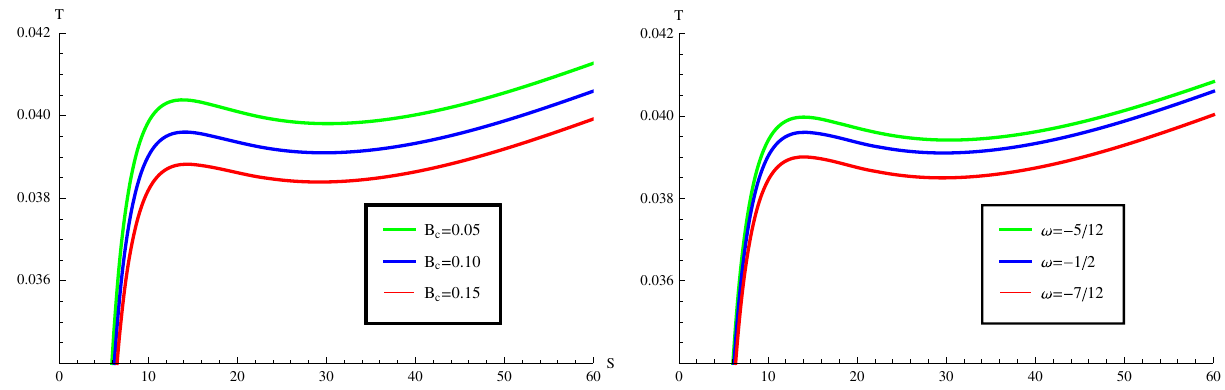
Fig. 3 The simulated phase transition and the boundary of a two-phase coexistence on the base of isobaric in the T – S diagram for charged anti-de Sitter black holes with differential B c and ω . The left figure shows Q = 1 ,ω = − 1 / 2, the right figure Q = 1 , B c = 0 . 1